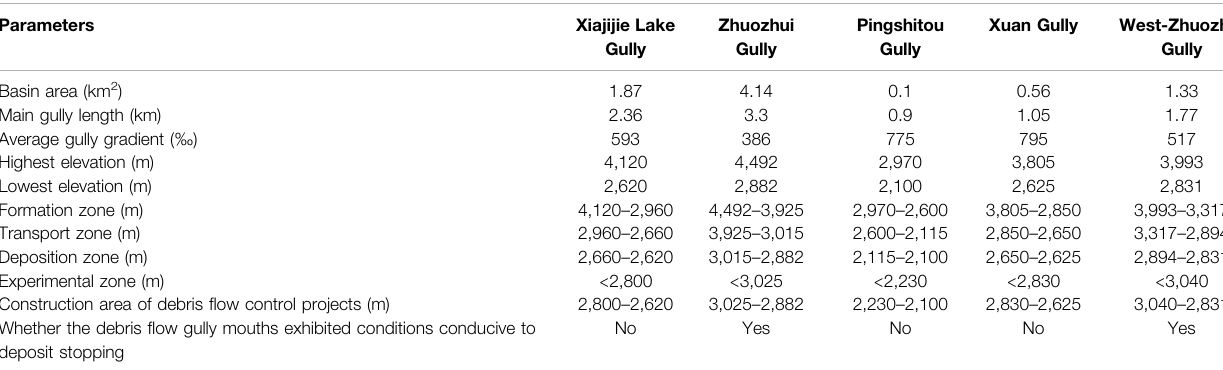
TABLE 2 | Topographic conditions of debris fl ow